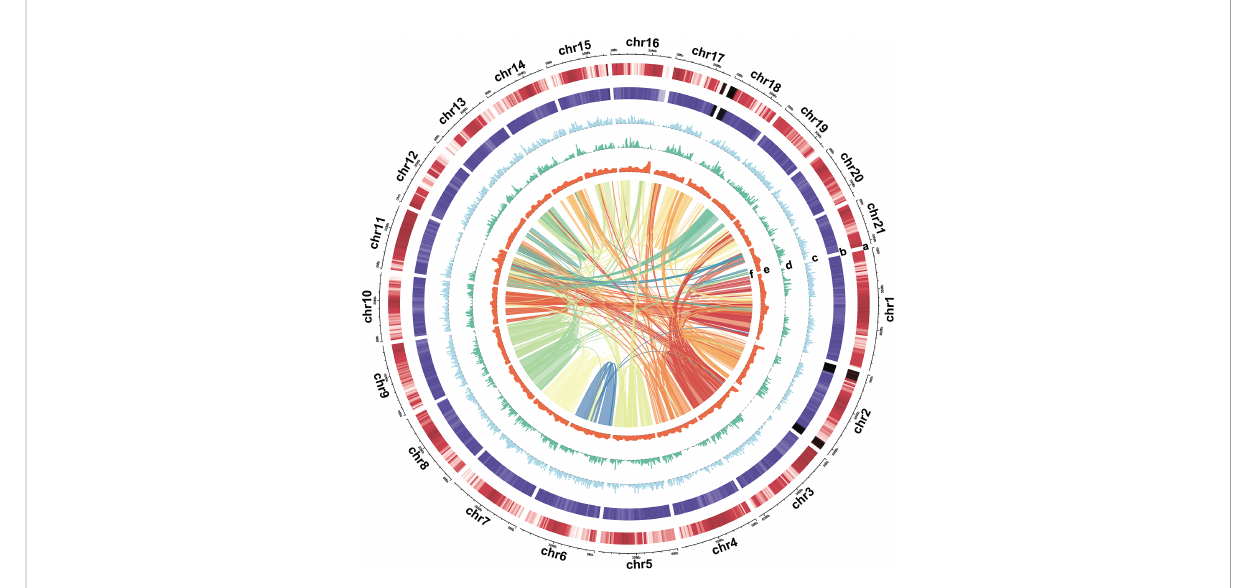
FIGURE 2 Characterization of the turmeric genome. Tracks: (A) Gene density, (B) GC content, (C) Copia density, (D) Gypsy density, (E) LTR assembly index (LAI), and (F) synteny